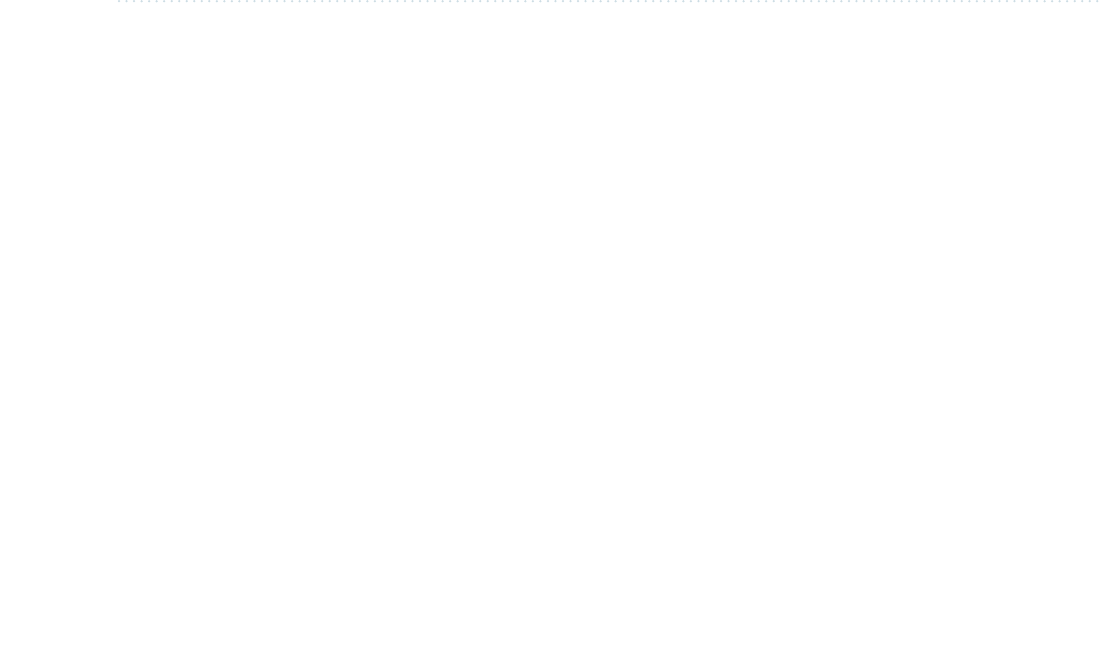
a for ( a ) orthotropic C–C–C–C plates and ( b ) E x = 2.5 and ν x ν y = ( 0.3 ) 2 (cid:31) (cid:31)